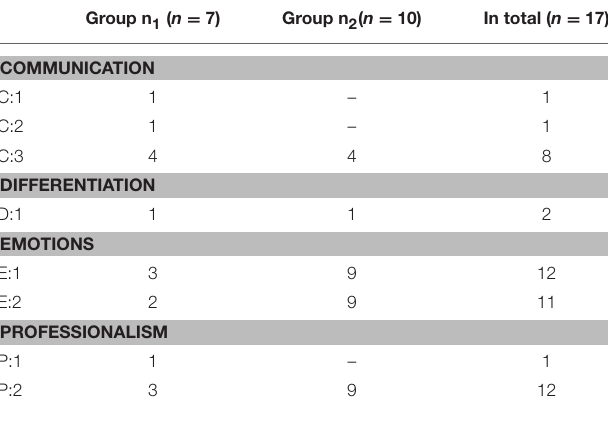
TABLE 1 | Comparison of analyses before access to explicit criteria for groups n 1 and n 2